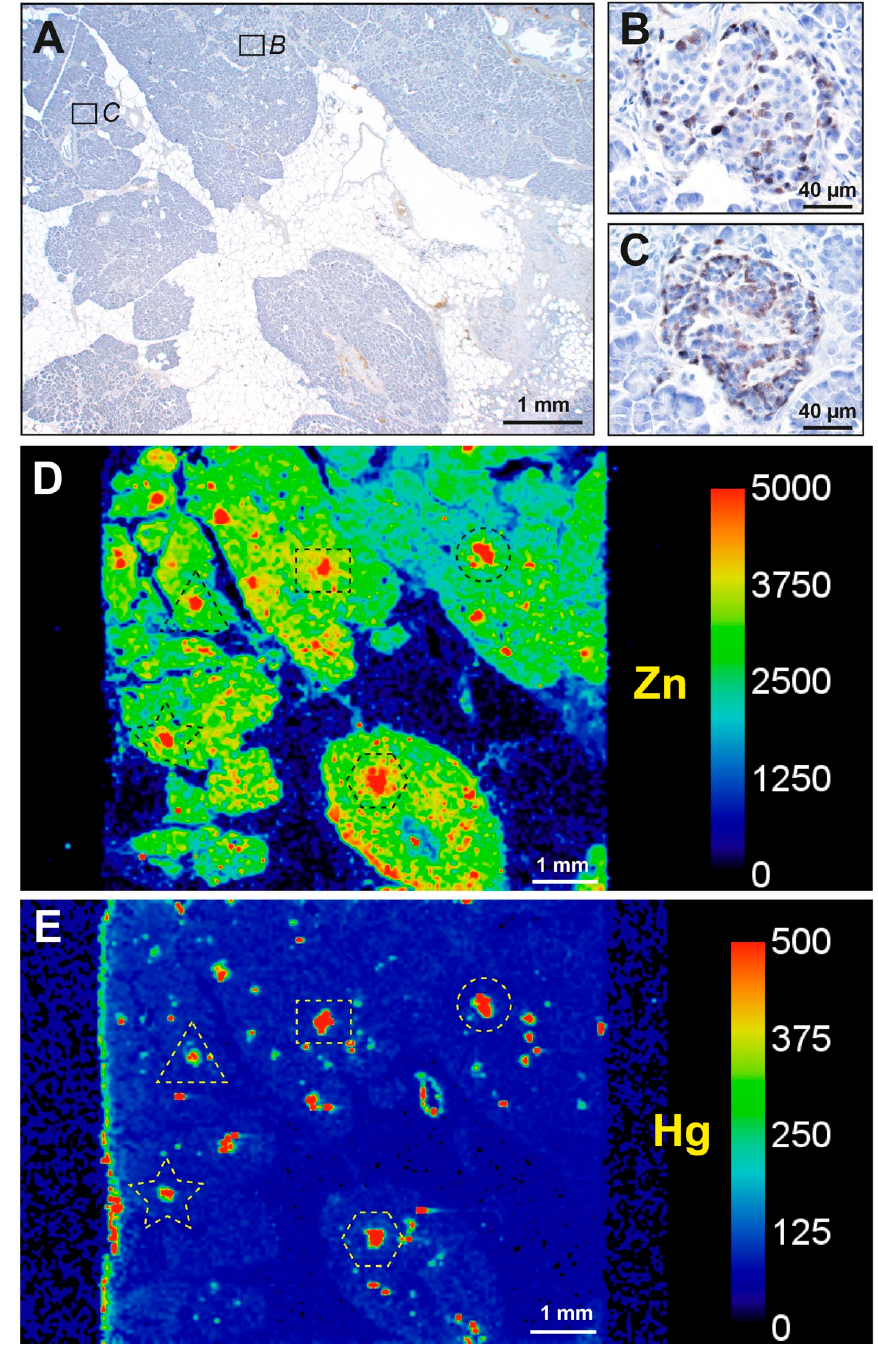
Figure 5. LA-ICP-MS confirmation of mercury detected by autometallography. ( A ) A low power image of an autometallography/hematoxylin-stained pancreas sample shows the exocrine tissue